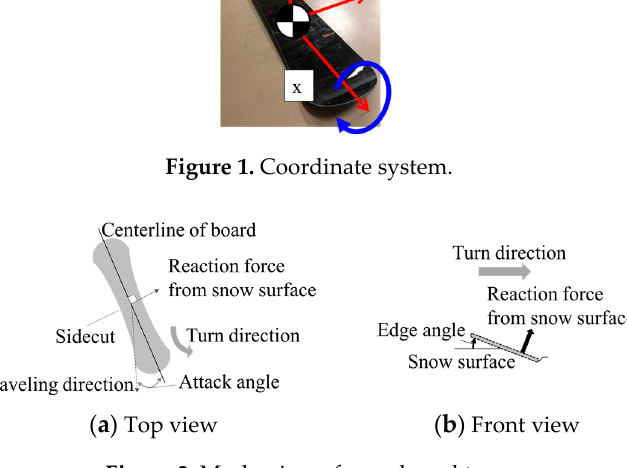
Figure 2. Mechanism of snowboard